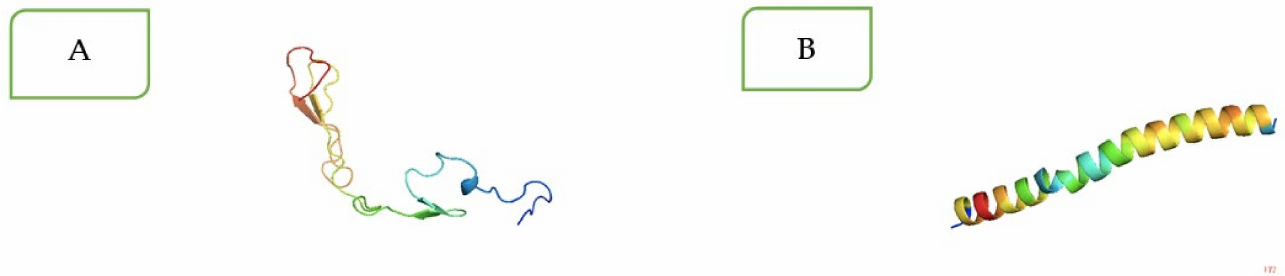
Figure 2. ( A , B ) The tertiary structure of the designed MEP construct VT1 ( A ) and VT2 ( B ). The VT1 3D structure modeling by Raptor-X based on the template with PDB ID 5b4xB, and the VT2 3D structure model is based on SWISS-MODEL.